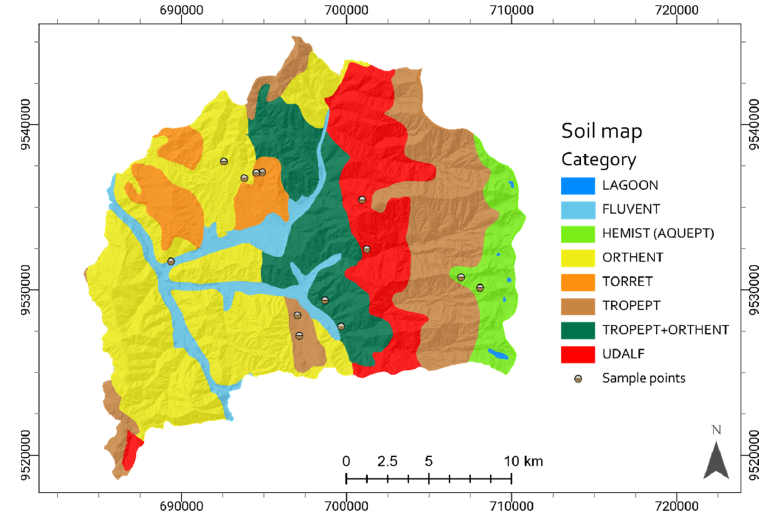
Figure 4. Soil map of the communities Malacatos and Vilcabamba (adopted from [33]), including sampling points.